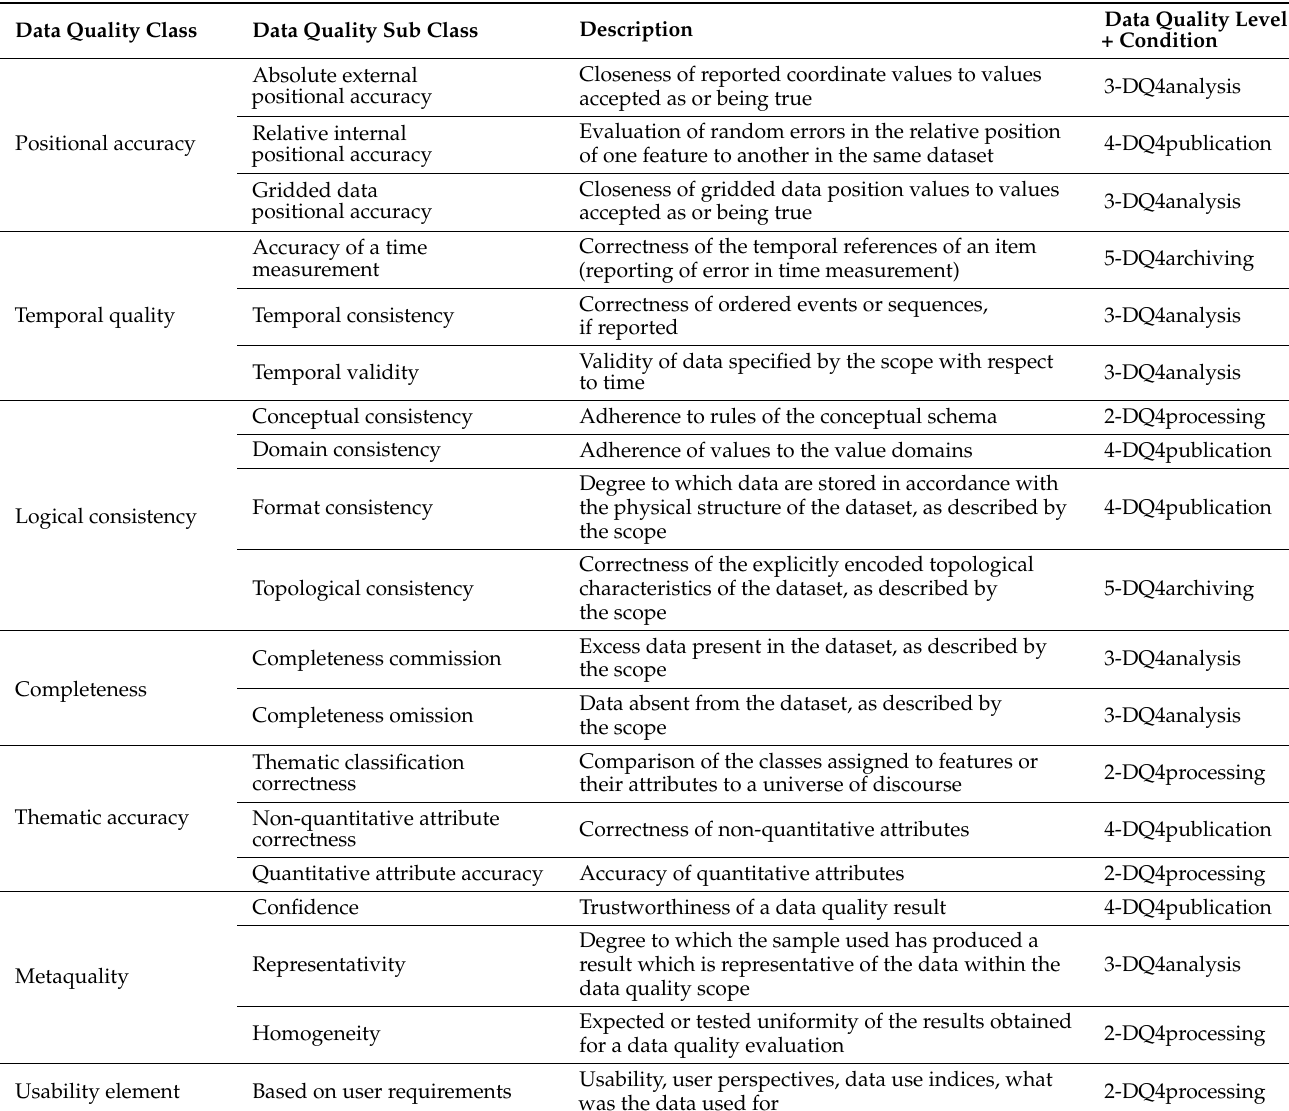
Table 6. Spatial data quality matrix with data quality classes and sub classes (ISO 19157:2013) and the data quality level and level condition from which the quality metric is required.